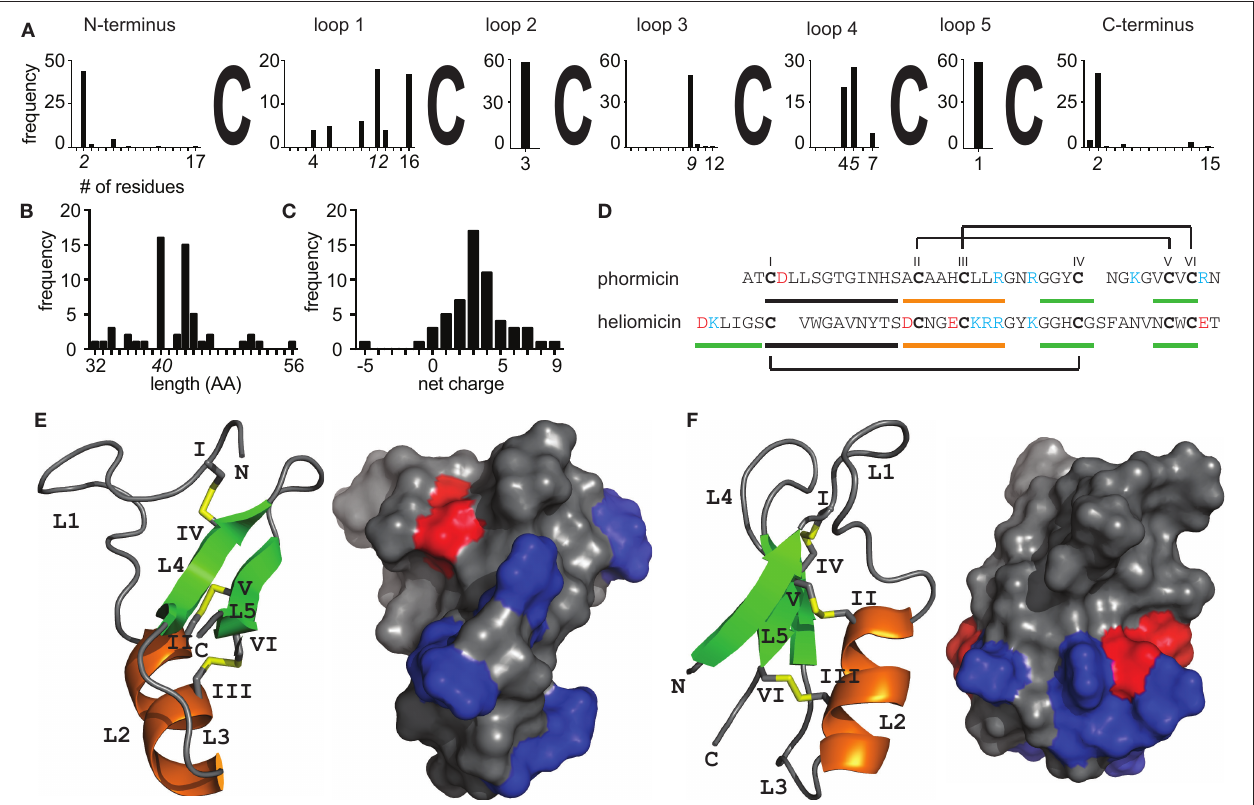
among defensin peptides across different organisms, from plants to invertebrates to vertebrates (Dias Rde and Franco, 2015; ( Figure 1A ) as well as their spectrum of antimicrobial activity varies considerably ( Table 1 ). It is evident that the majority